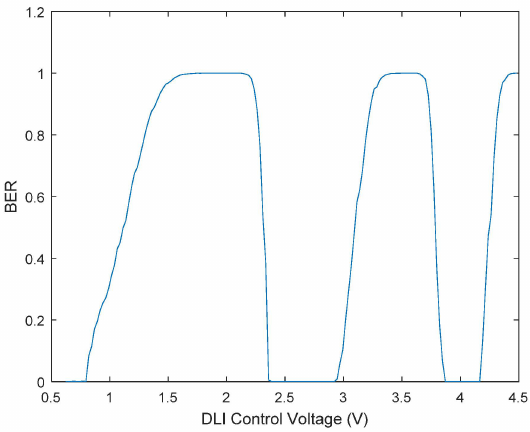
Figure 6. Improved dynamic DLI control voltage adjusting.